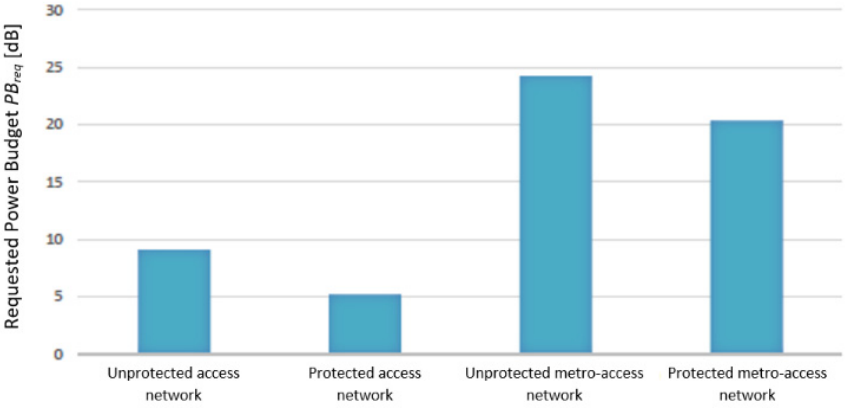
Figure 3. The comparison of power budget requirements for RING WDM-PON protection schemes.